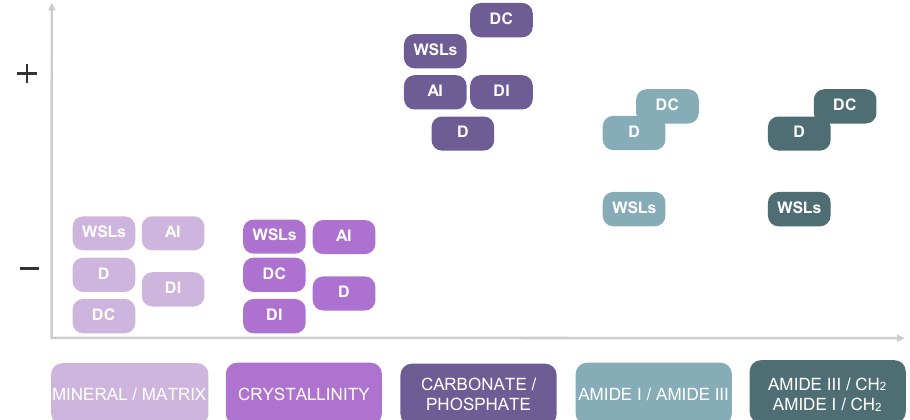
Figure 4. Variations of the main Raman-derived spectral parameters in relation to different dental pathologies (WSLs: white spot lesions; D: dentin; DC: dental caries; AI: amelogenesis imperfecta; DI: dentinogenesis imperfecta).